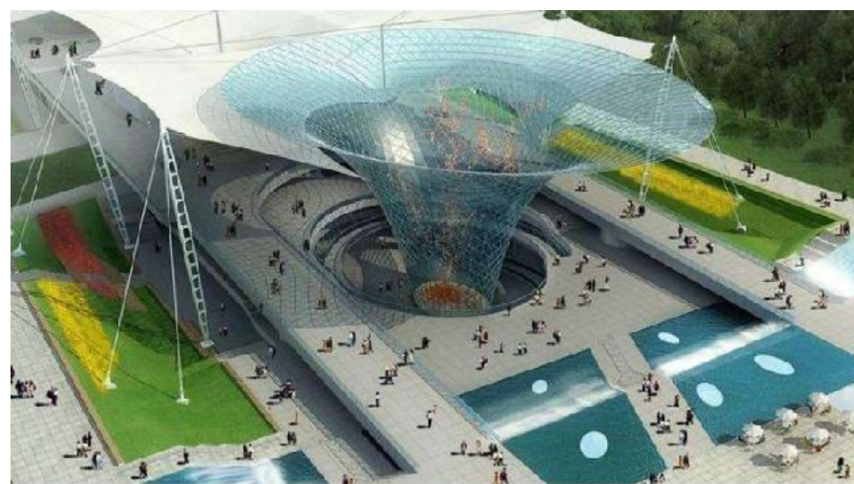
Fig. 18 Expo Axis and underground complex